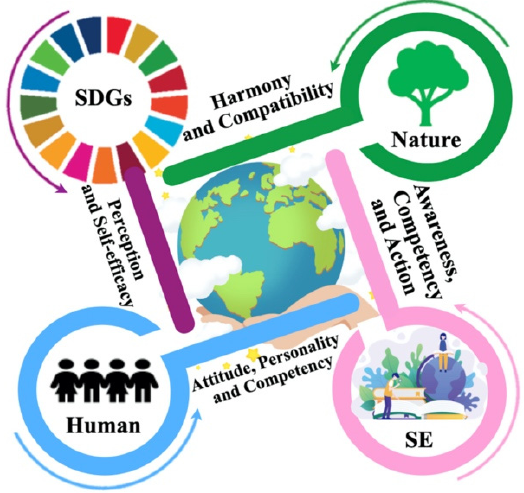
Figure 1. Scheme for investigating the importance of perception and self-efficacy with regard to the SDGs for the SE to advance the harmony and compatibility between humans and nature (own cre- ation).